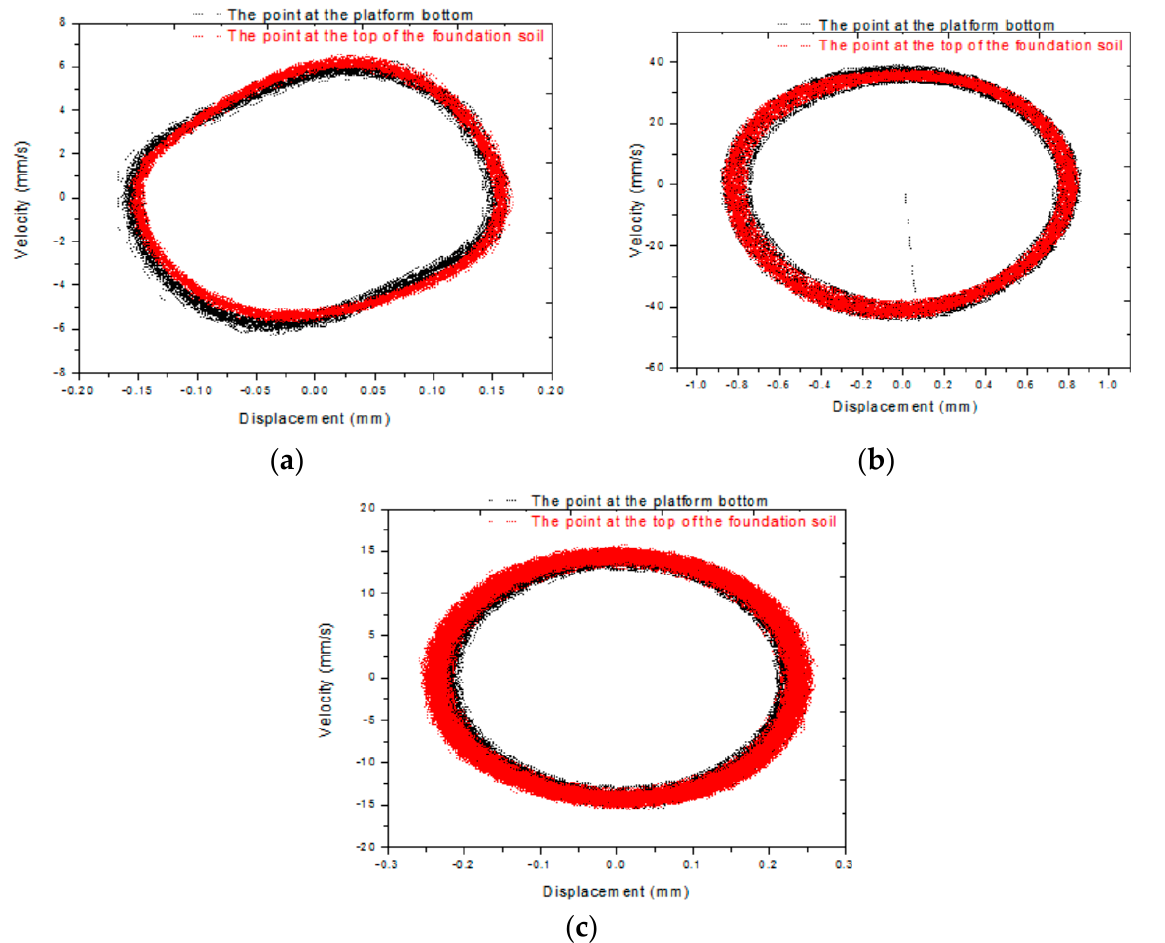
Figure 12. Phase-Plane Curves of “Adjacent” Measuring Points at Pile Cap-Soil Interface under Sinusoidal Excitation: ( a ) S5-1, ( b ) S5-2, ( c ) S10.